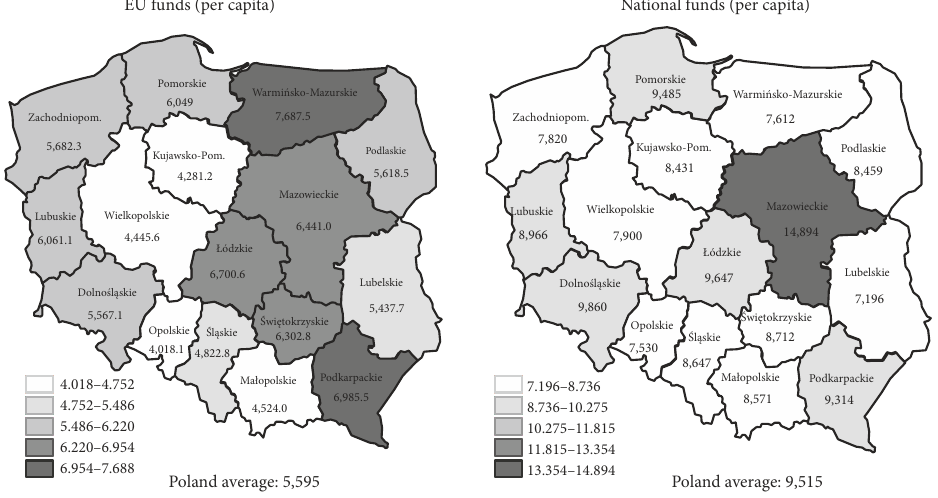
Figure 1. EU structural funds and national structural expenditure (per capita, PLN) in Polish regions in 2004–2013 (source: own calculations based on data from The Ministry of Infrastructure and Development (Chrzanowski, 2015, pp. 127–131; Program Polska Wschodnia 2014–2020,